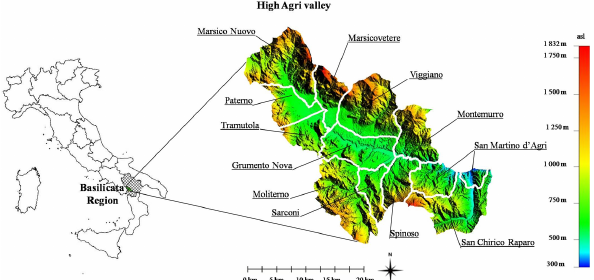
Figure 1. Location of the study area within the Basilicata region (southern Italy). The zoom shows the administrative limits of the municipalities of the high Agri Valley overlapped on the digital el- evation model (DEM) of the area provided by the Basin Authority of the region at 20m